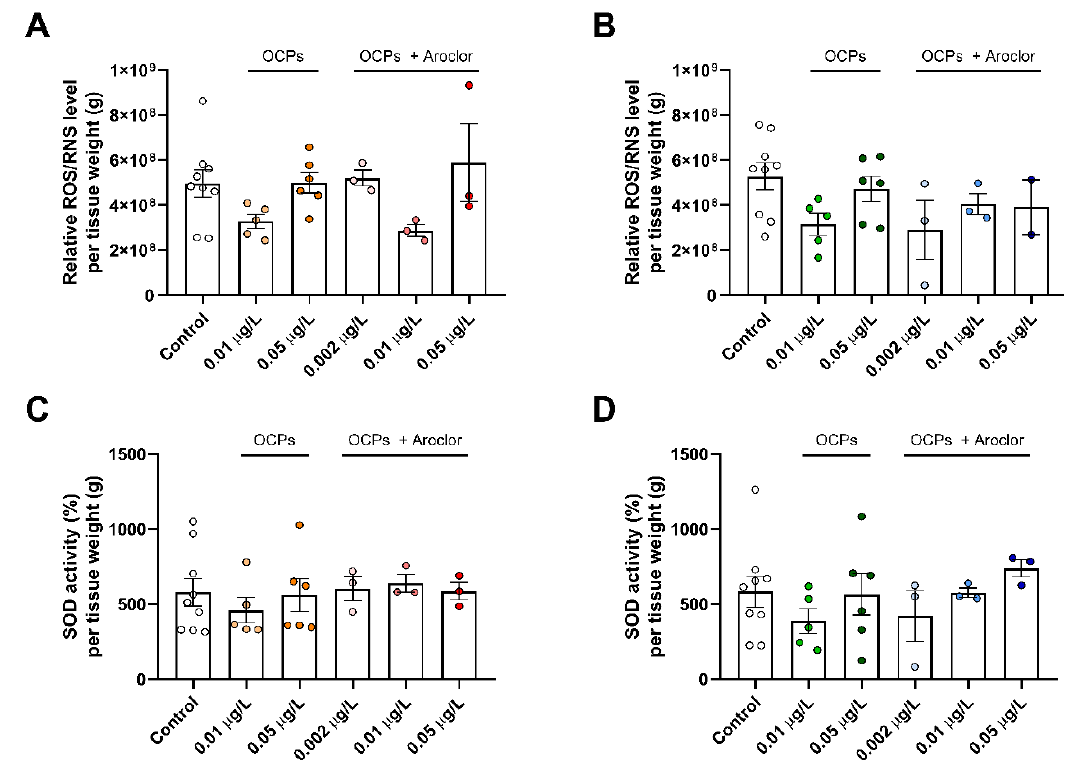
Figure 2. Relative reactive oxygen species (ROS)/reactive nitrogen species (RNS) levels of ( A ) females and ( B ) males and superoxide dismutase (SOD) activity of ( C ) females and ( D ) males. All data were normalized based on the weight of the tissue. Control groups are shown as white dots, 0.01 µ g/L organochlorine pesticide (OCP)-exposed females as yellow dots, 0.05 µ g/L OCP-exposed females as orange dots, 0.002 µ g/L OCP-and-Aroclor-exposed females as light pink dots, 0.01 µ g/L OCP-and-Aroclor-exposed females as pink dots, 0.05 µ g/L OCP-and-Aroclor-exposed females as red dots, 0.01 µ g/L OCP-exposed males as green dots, 0.05 µ g/L OCP-exposed males as dark green dots, 0.002 µ g/L OCP-and-Aroclor-exposed males as light blue dots, 0.01 µ g/L OCP-and-Aroclor-exposed males as blue dots, and 0.05 µ g/L OCP-and-Aroclor-exposed males as navy blue dots. Results represent the mean and